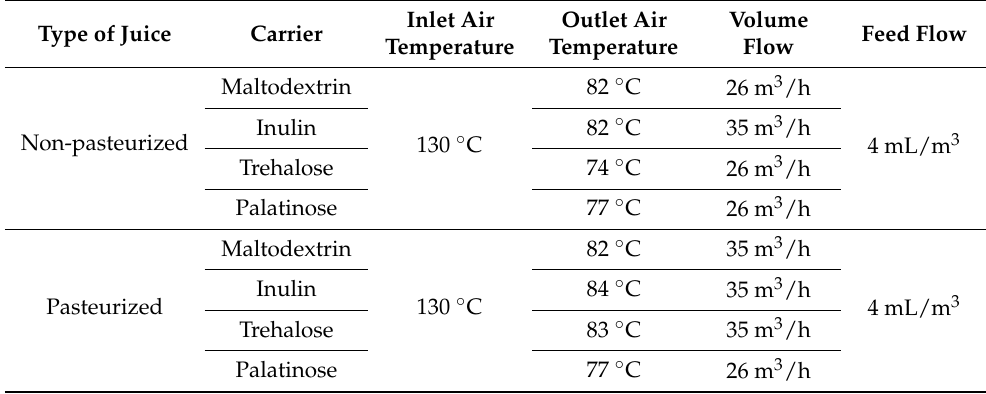
Table 1. Spray drying parameters set up for the preparation of rosehip juice powders in dependence of the carrier